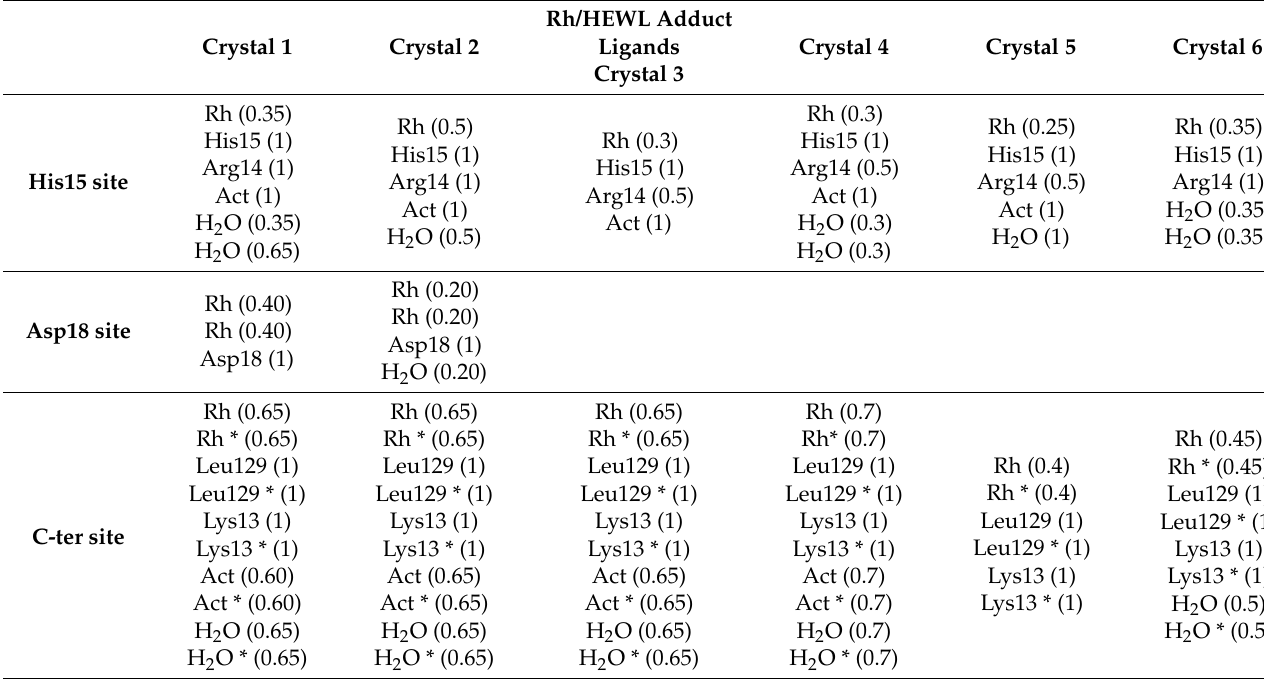
Table 2. Rh binding sites found in the six structures of Rh/HEWL adducts obtained upon reaction of the protein with [Rh 2 ( µ -O 2 CCH 3 ) 4 ]. Table describes the ligands at each Rh binding site. Values in parentheses refer to the occupancy of metal and ligands.* refers to atoms from symmetry related